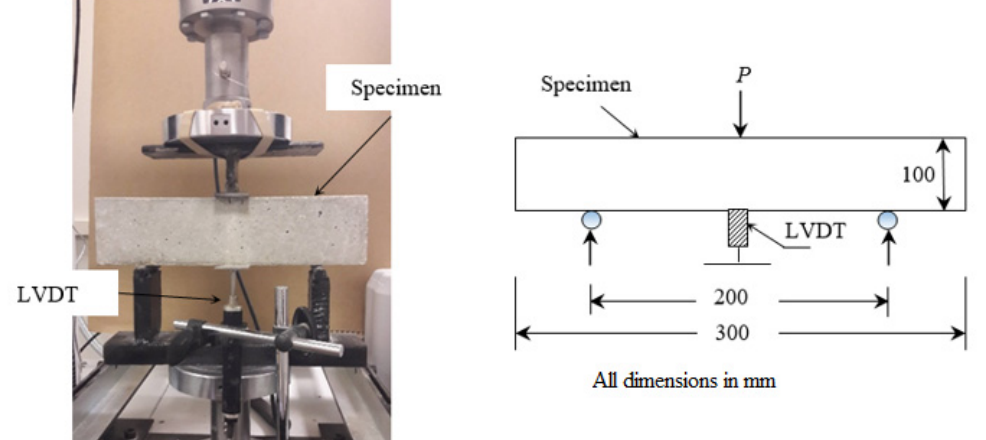
Figure 3. Three-point flexural test setup.